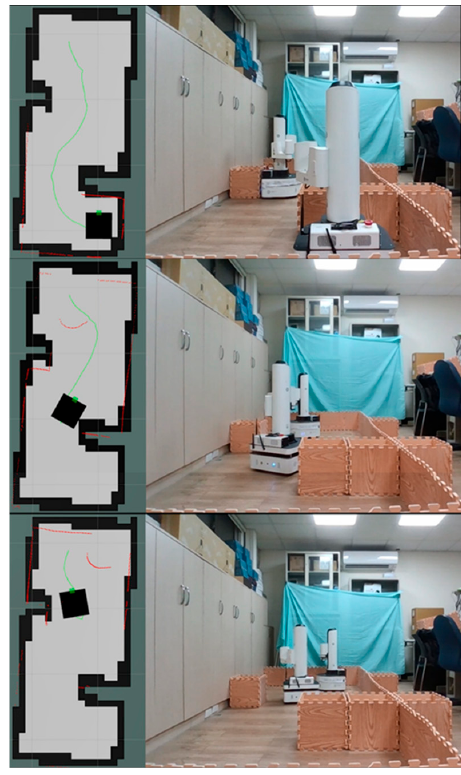
Figure 15. The path planning result in the environment with an unknown moving obstacle by the A*